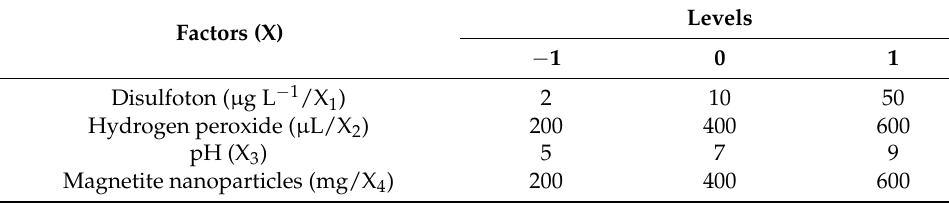
Table 1. Experimental domain for a 2 4 factorial experimental design. Factors (X)